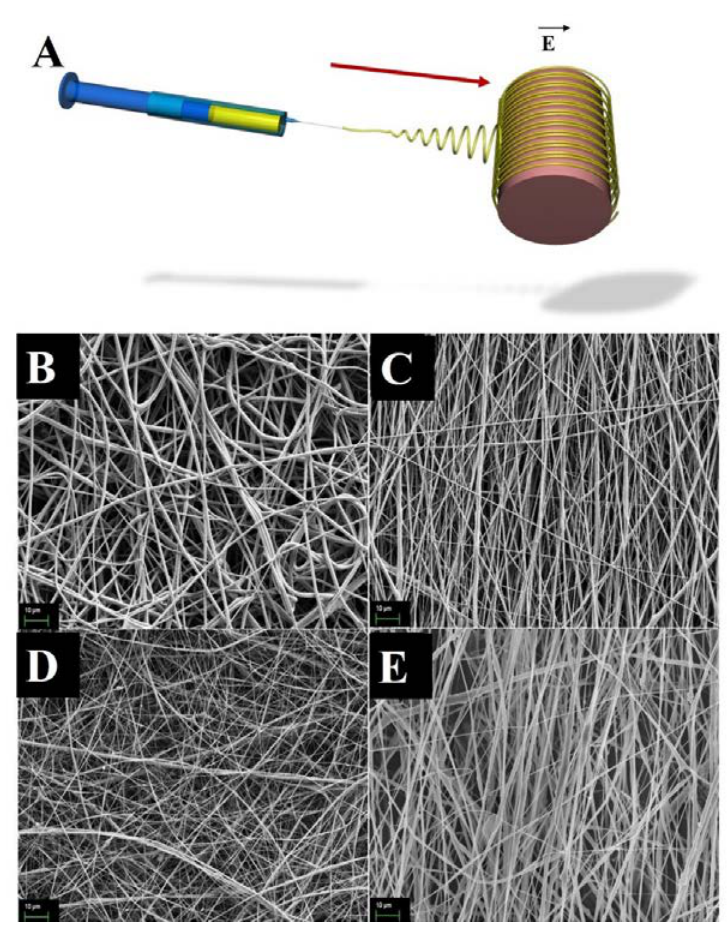
Figure 1. ( A ) Schematic illustration showing the electrospinning setup, field emission scanning electron microscopy(FESEM)imageshowingthe( B )pristinepolyvinylidenefluoride(PVDF)randomnanofiber(NF) (PNF), ( C ) pristine PVDF aligned NF, ( D ) PVDF-graphene oxide (GO) random NF (PGRNF), ( E ) PVDF-GO aligned NF (PGANF).